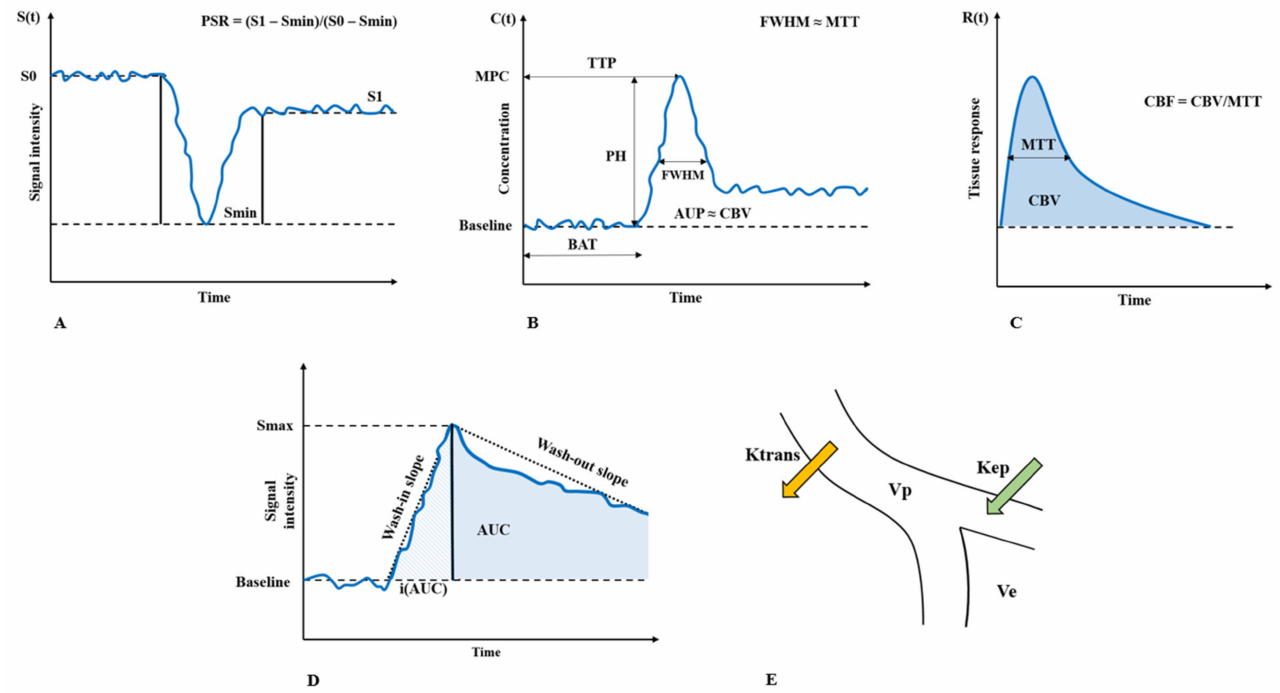
Figure 2. The derivation of perfusion parameters from the signal-response time curve is shown. The signal response time-curve is acquired during contrast bolus passage in the studied region-of-interest. From the signal response time-curve the changes of bolus concentration are estimated (tissue bolus concentration time-curve). Tissue bolus concentration time-curve is processed with mathematical models enabling a qualitative, semi-quantitative or quantitative assessment/measurement of perfu- sion parameters. Panel ( A ) Simplified signal response time curve acquired during DSC-MRI. Panel ( B ) Simplified tissue bolus concentration time-curve. Panel ( C ) Deconvoluted tissue bolus concentration time-curve to tissue response time-curve. Panel ( D ) Simplified signal response time-curve acquired during DCE-MRI. Panel ( E ) Schematic representation of permeability parameters derived from DCE- MRI. (Adapted from Zhang, J.; Liu, H.; Tong, H.; Wang, S.; Yang, Y.; Liu, G.; Zhang, W. Clinical Appli- cations of Contrast-Enhanced Perfusion MRI Techniques in Gliomas: Recent Advances and Current Challenges. Contrast Media Mol. Imaging 2017 , 2017 , 7064120.